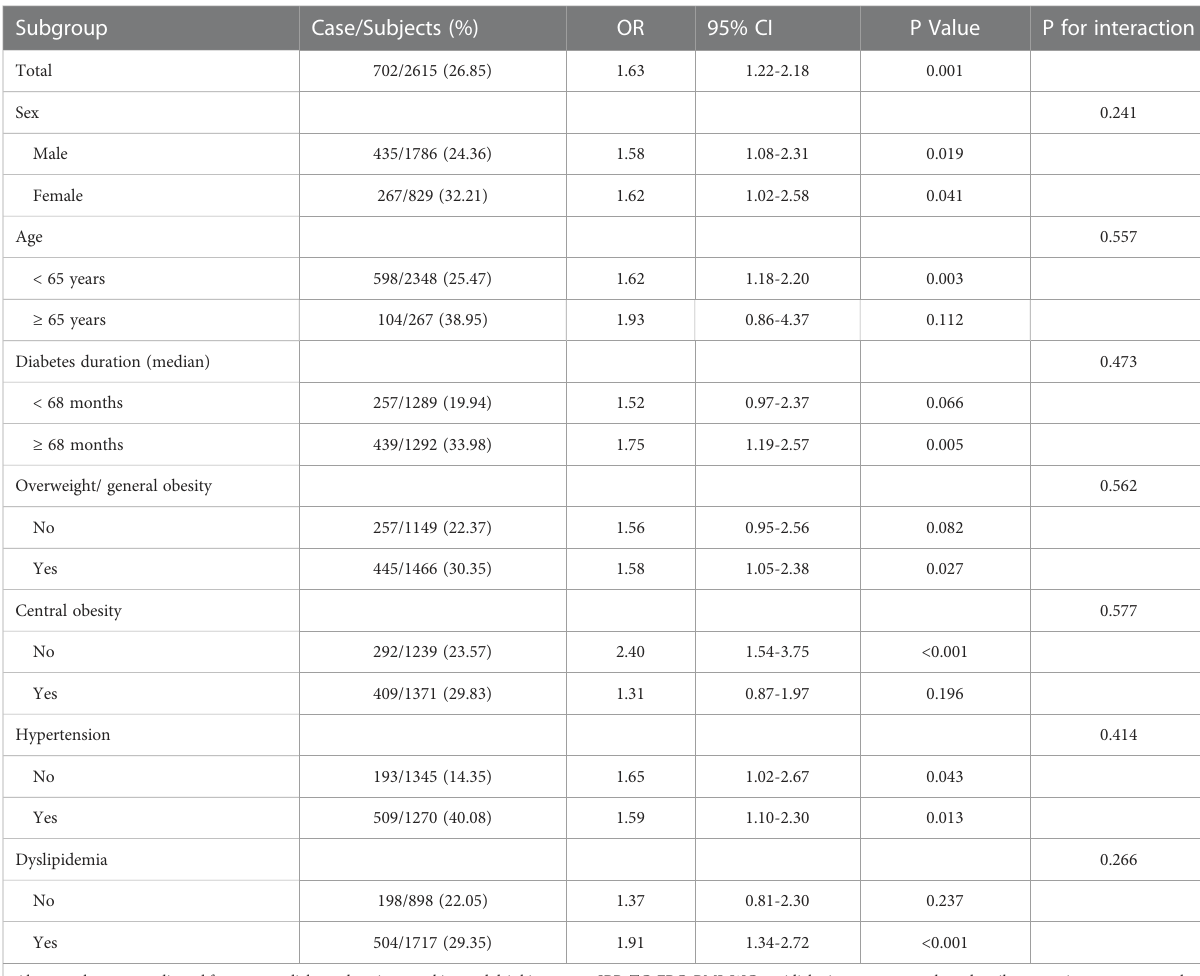
TABLE 4 Subgroup analyses on the association of NHR with the prevalence of DKD in T2DM patients.